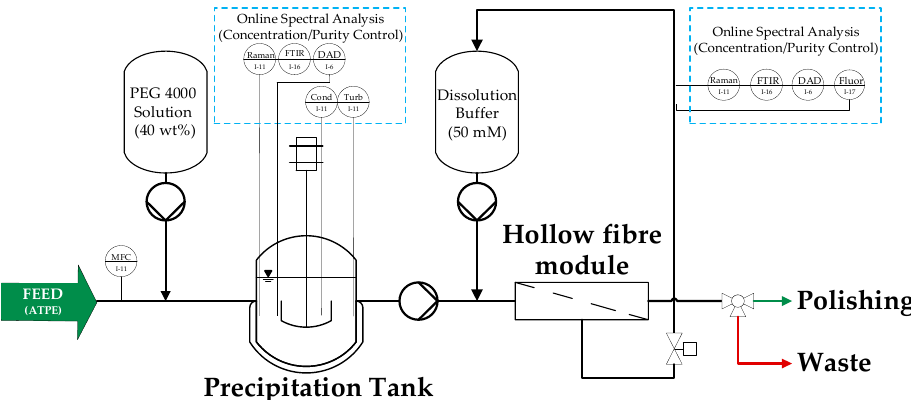
Figure 1. Simplified illustration of a precipitation subunit with the tested online measurement.